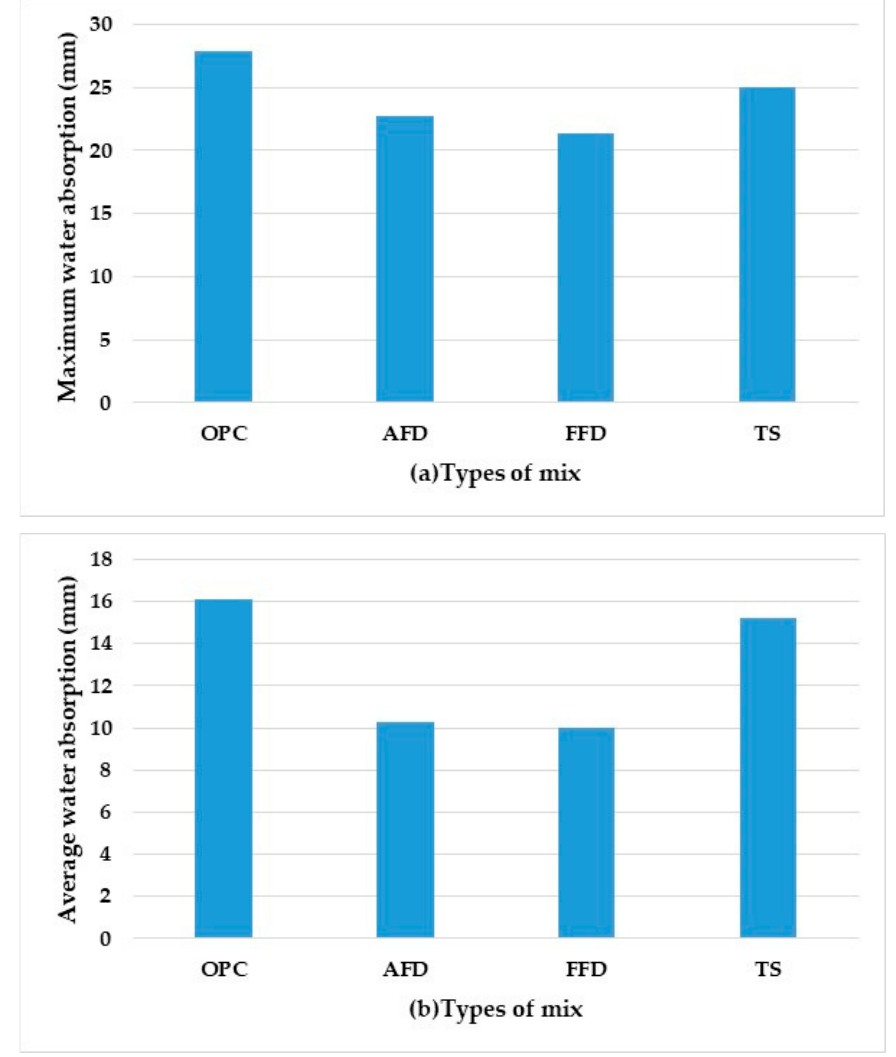
Figure 7. ( a ) Maximum water absorption. ( b ) Average water of different mix types. Table 4. Compressive